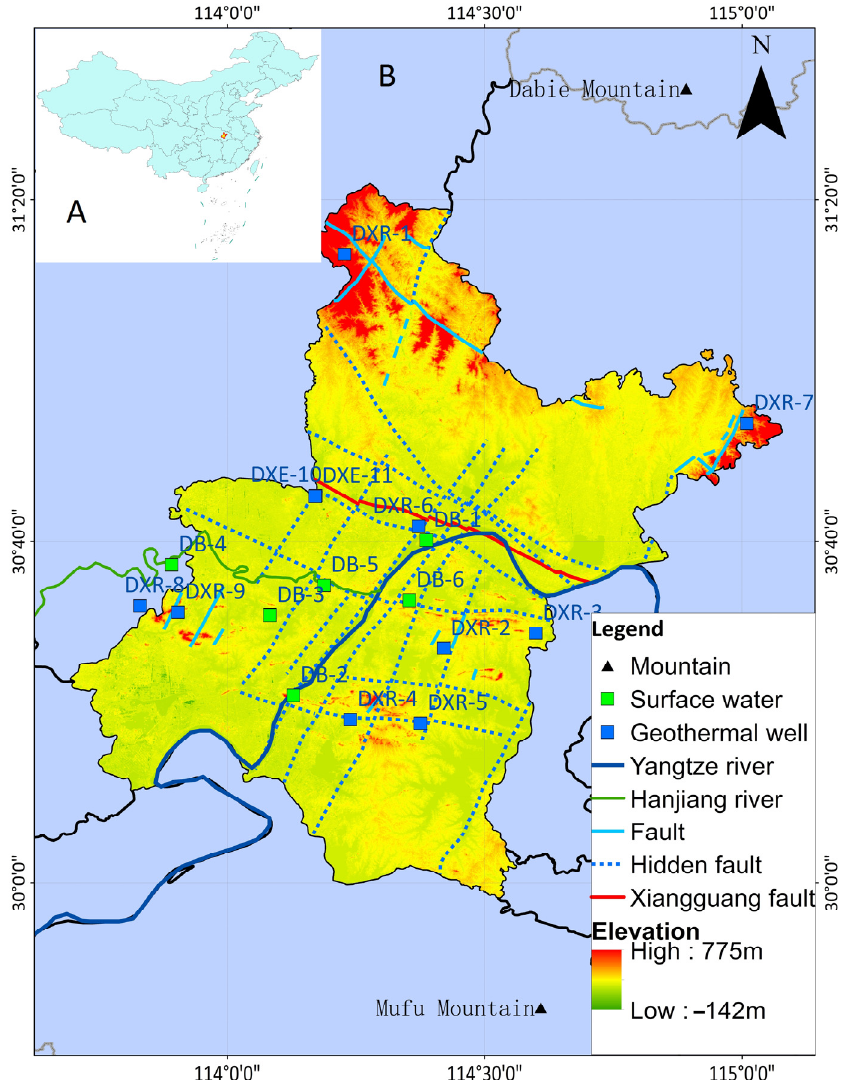
Figure 1. Geological sketch and sampling point location map of the study area. Figure A : The main purpose is to indicate the specific location of the study area in China. Figure B : It contains information on elevation and fault structure and points out the location of sampling points of geothermal wells and surface water in detail.